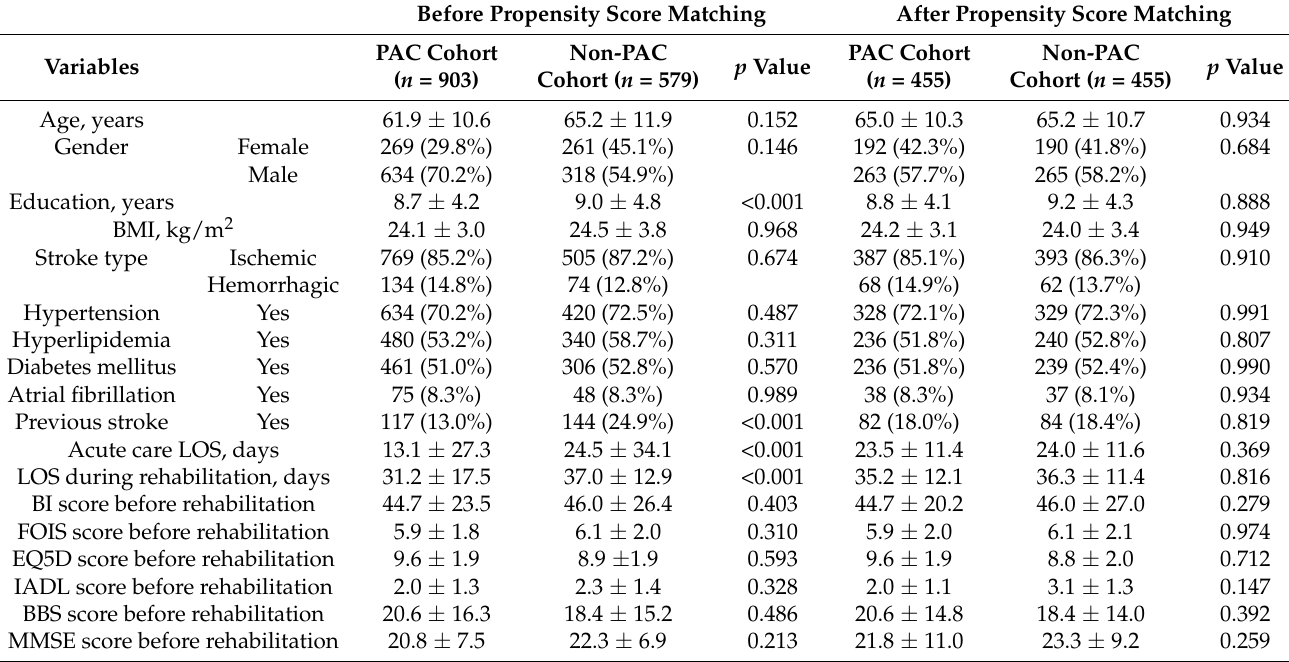
Table 1. Stroke patient characteristics.